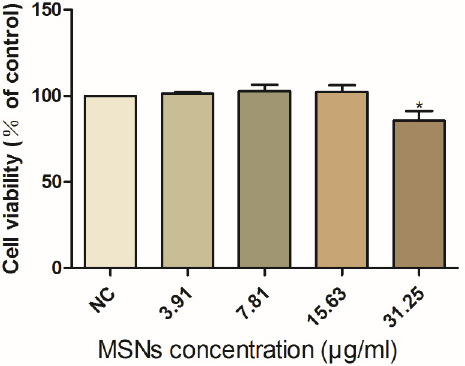
Figure 2. Toxicity detection of MSNs on im-DCs. Different concentrations of MSNs were incubated with im-DCs for 24 h, and the viability of DCs was assessed. Data were presented as mean ± SD of three duplicate samples. Differences were considered significant at (*) p < 0.05.